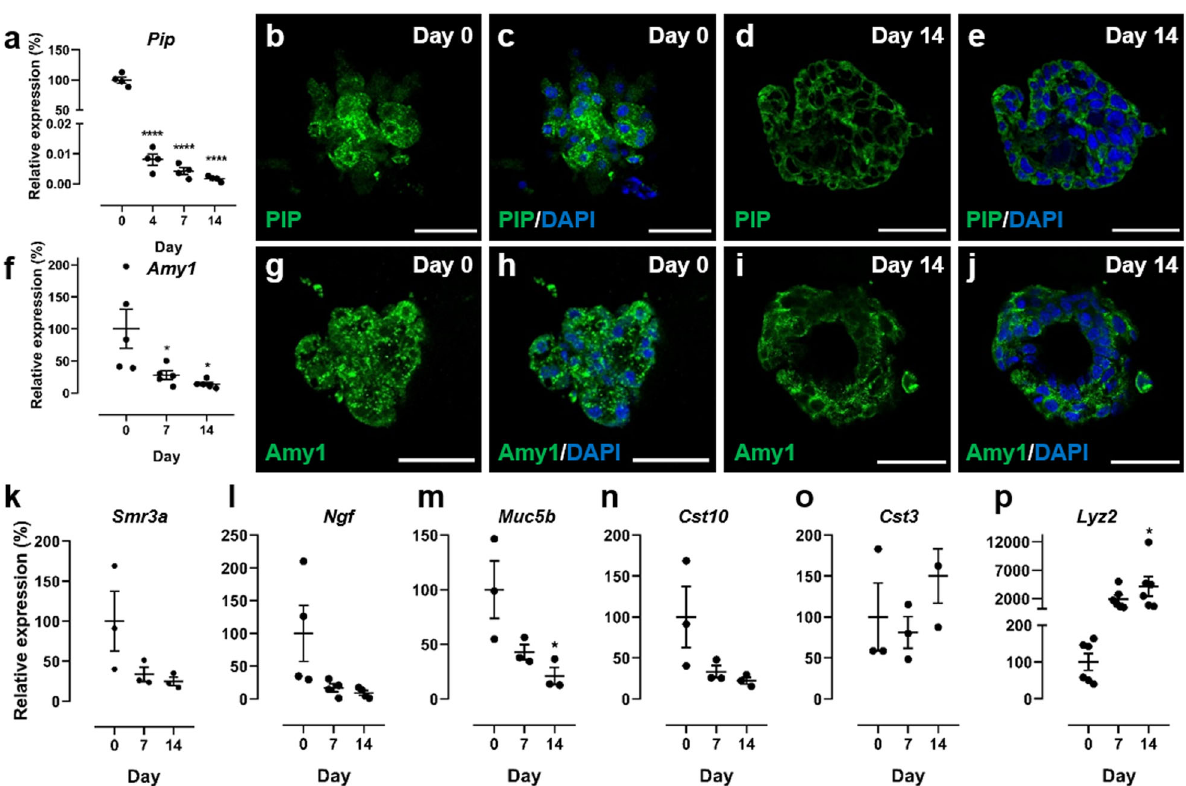
Fig. 3 SGm in MB-hydrogels retain expression of secretory proteins. a Gene expression of the secretory protein Pip . b – e PIP immunohistochemical staining at days 0 and 14. f Gene expression of amylase. g – j Amylase (Amy1) immunohistochemical staining at days 0 and 14. Scale bars = 40 μ m. k – p Gene expression of Smr3a ( k ), Ngf ( l ), Muc5b ( m ), Cst10 ( n ), Cst3 ( o ), and Lyz2 ( p ) determined using qPCR. All gene expression data is relative to day 0 with housekeeping gene Rps29 . Statistics were performed using ANOVA with Dunnett ’ s post-hoc test compared to day 0. * p < 0.05; ** p < 0.01; *** p < 0.001; **** p < 0.0001; N = 3 –